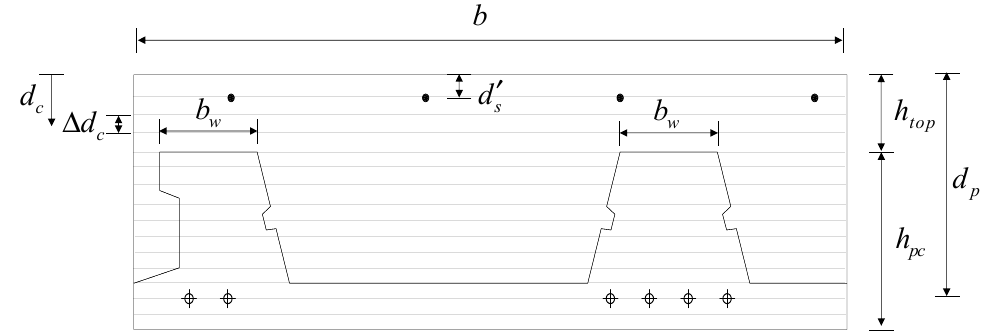
Figure A1. Section details of JAS.